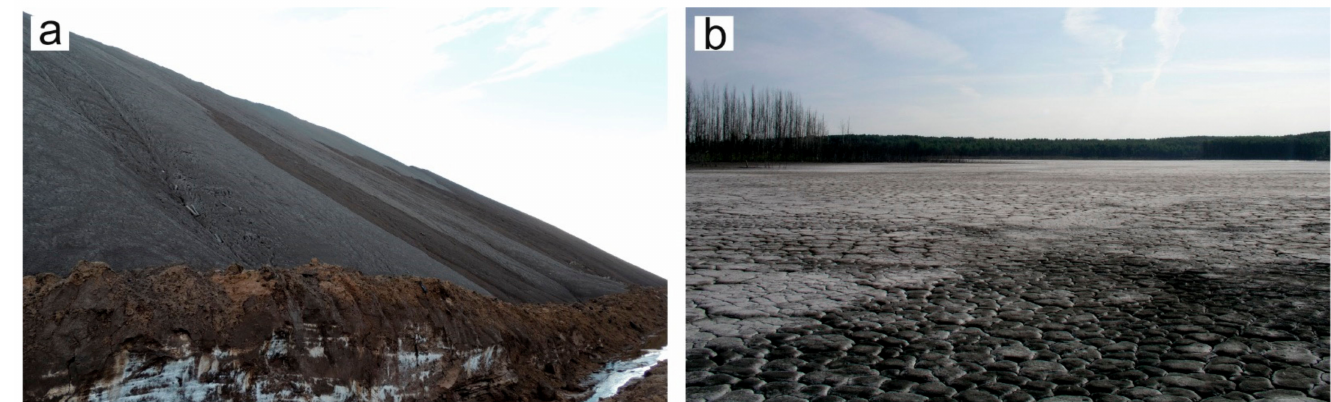
Figure 2. Potash waste storages: ( a ) slurry storage facility; ( b ) salt tailing pile with